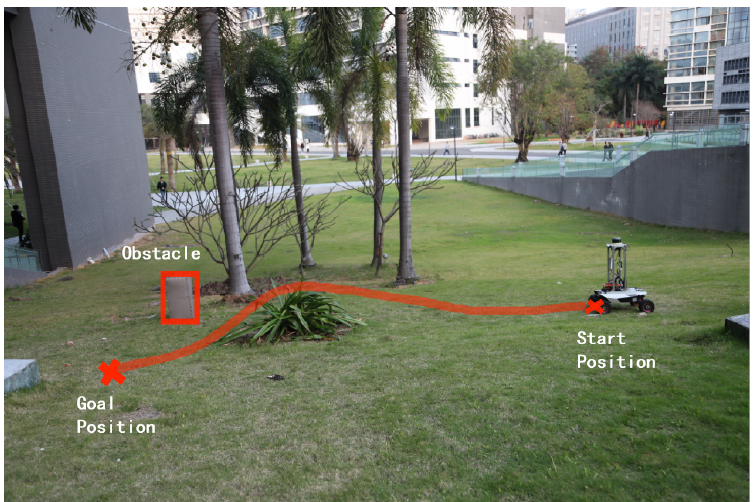
Figure 6. The robot’s path in Exp 1 resulting from the integrated improved A (cid:63) algorithm and Q -learning